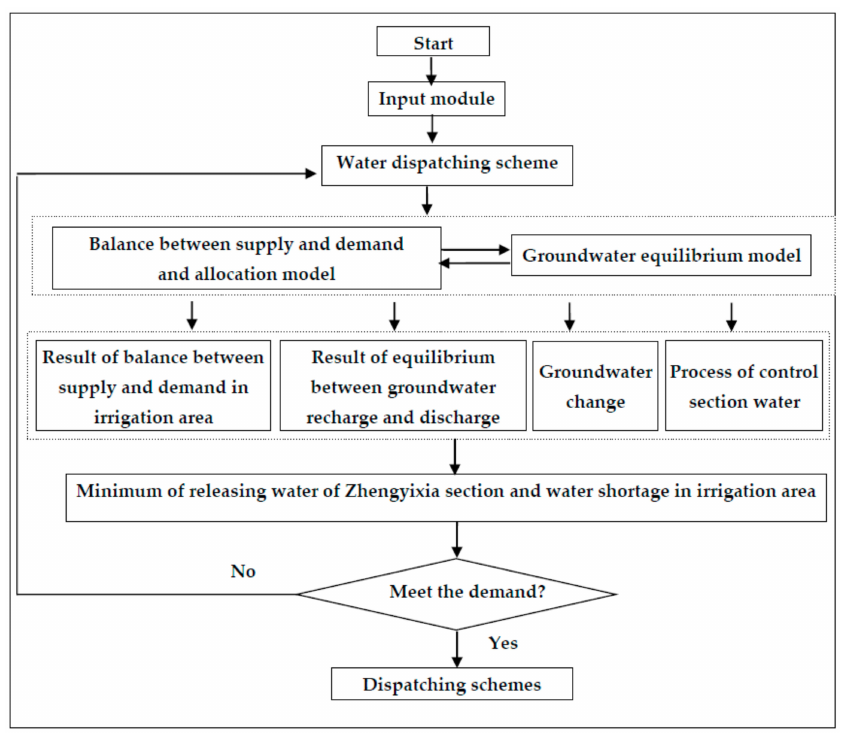
Figure 2. Framework of the water resource allocation